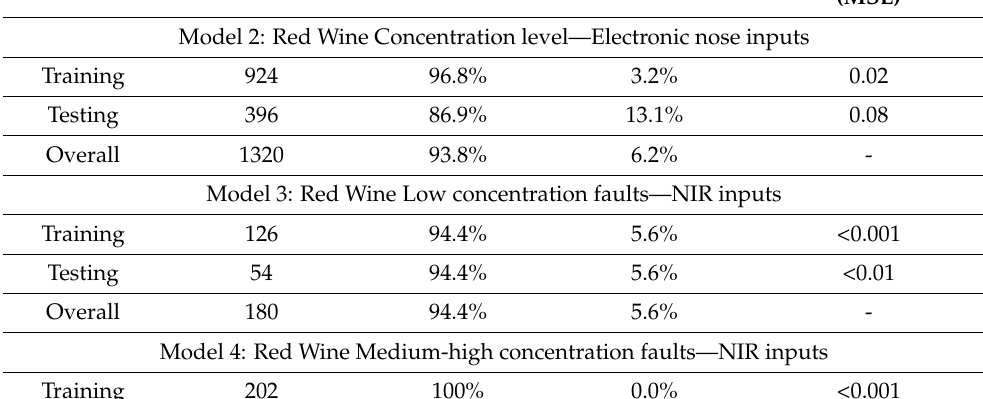
Table 3. Cont . Stage Samples